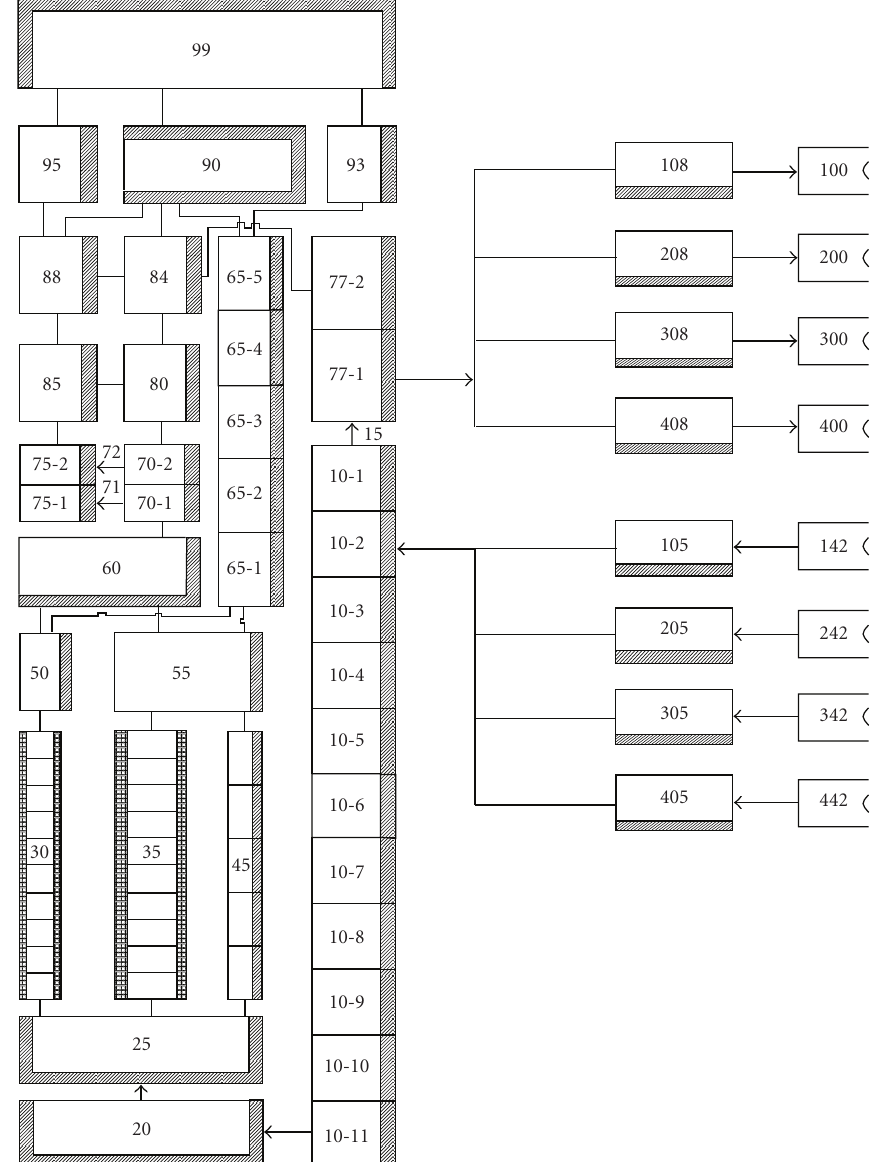
Figure 17: Representative vessel input nodalization for VVER-1000 for transients not including the possibility of loss of core